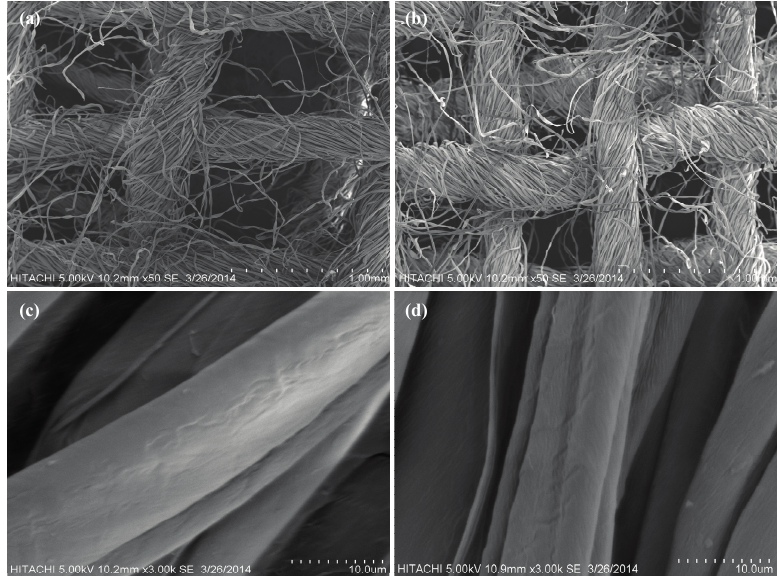
Figure 3. SEM (scanning electron microscope) micrographs of the surfaces of the ( a ) untreated CW; ( b ) treated CW (at magnification of 50×); ( c ) untreated CW and